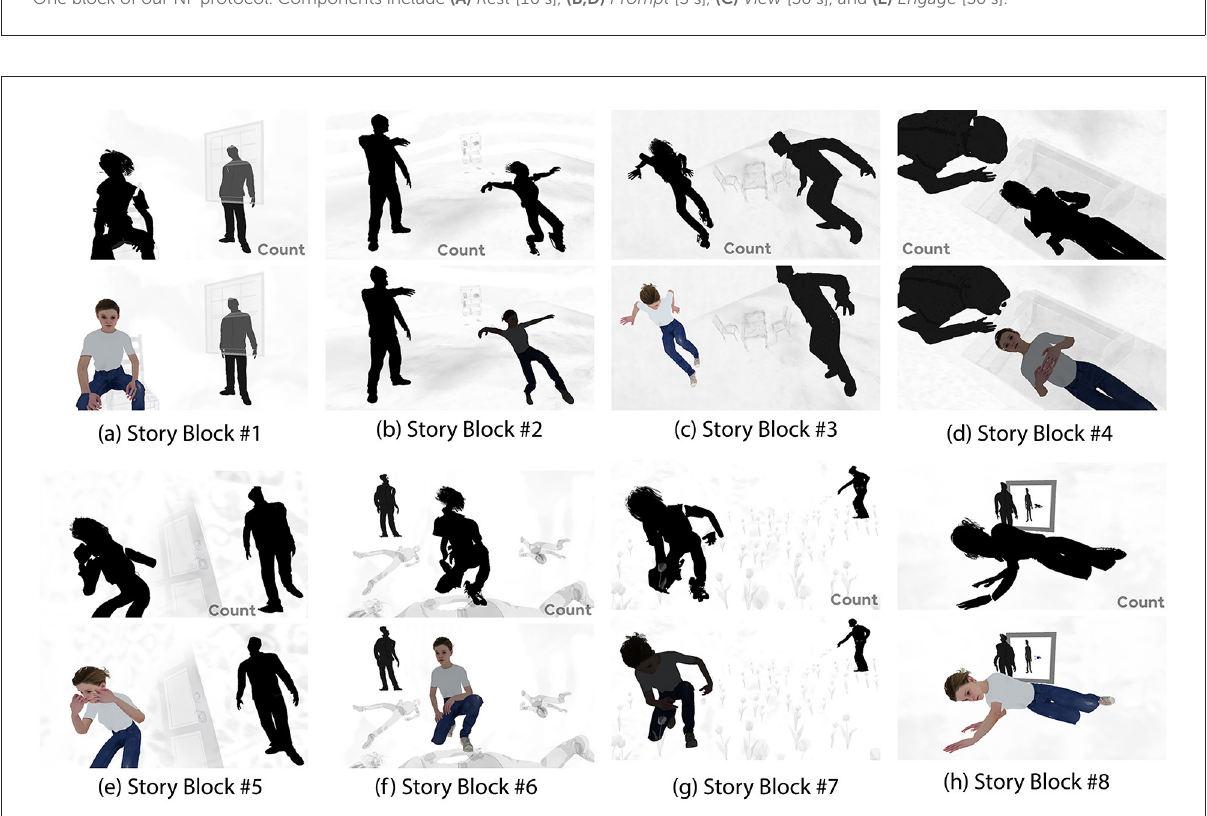
FIGURE2 All eight story blocks, with View and Engage components. 2b and 2g demonstrate FAA which has not crossed the threshold for visual feedback, therefore, the 3d model remains dark. (a) Story block #1, (b) Story block #2, (c) Story block #3, (d) Story block #4, (e) Story block #5, (f) Story block #6, (g) Story block #7, (h) Story block